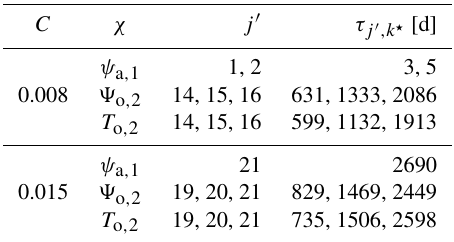
Table 1. Mode indices j (cid:48) and corresponding k (cid:63) -variate timescales τ j (cid:48) ,k (cid:63) (see Eq. 5) used for the reconstruction based on empirical modes R χ, 95%